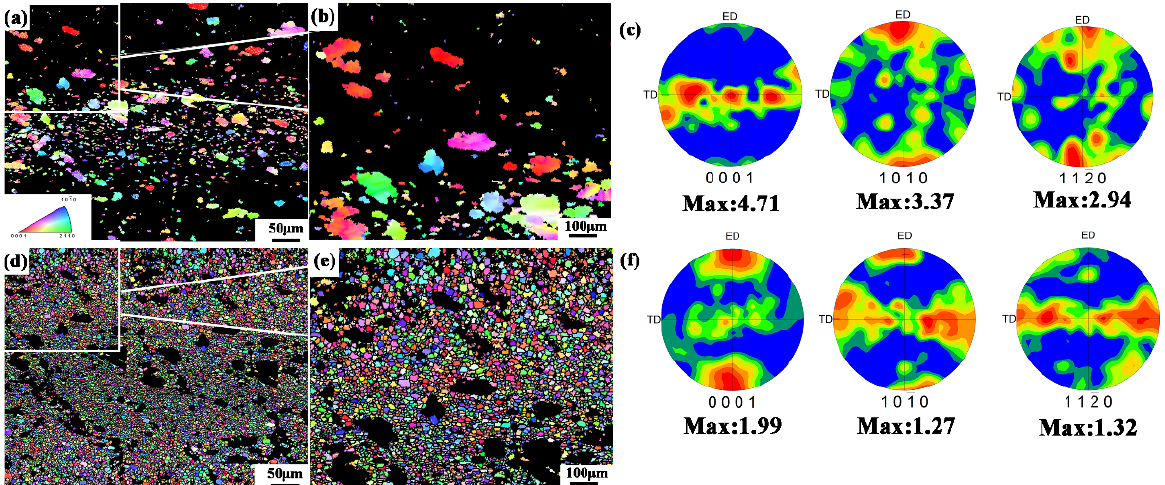
Figure 4. EBSD analysis of initial Mg-13Gd-4Y-2Zn-0.4Zr billet: ( a , b ) EBSD map of deformed grains ( d , e ); EBSD map of DRX grains; ( c ) Pole figure (PF) analysis of deformed grains; ( f ) Pole figure (PF) analysis of DRX grains. ( b , e ) are partial enlarged views of the white square frame areas in ( a , d ), respectively.